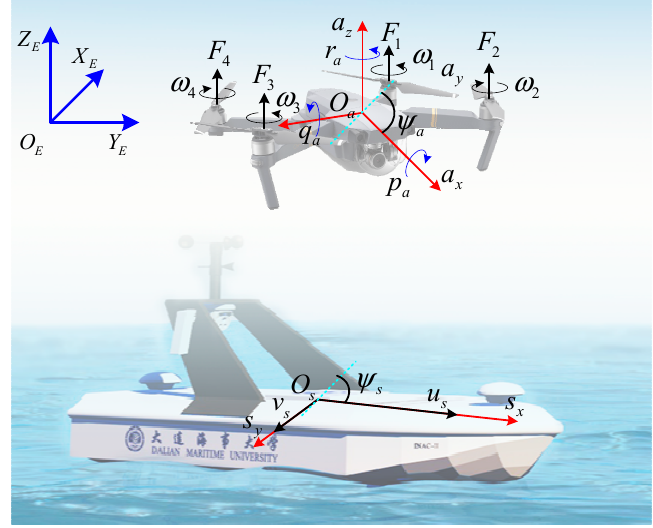
Figure 1. Variables interpretation for cooperative USV-UAV system.